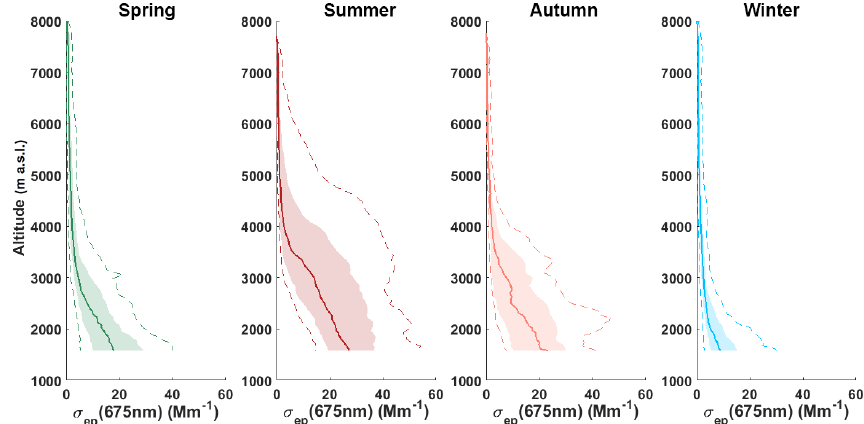
Figure 5. Seasonal variability of vertical profiles of aerosol extinction coefficients at 675nm. The line represents the median and the shadowed area is the interquartile range. The dashed lines represent the 10th and 90th percentiles. Seasonal statistics are based on daily averaged profiles. Spring corresponds with March, April and May; summer with June, July and August; autumn with September, October and November; and winter with December, January and